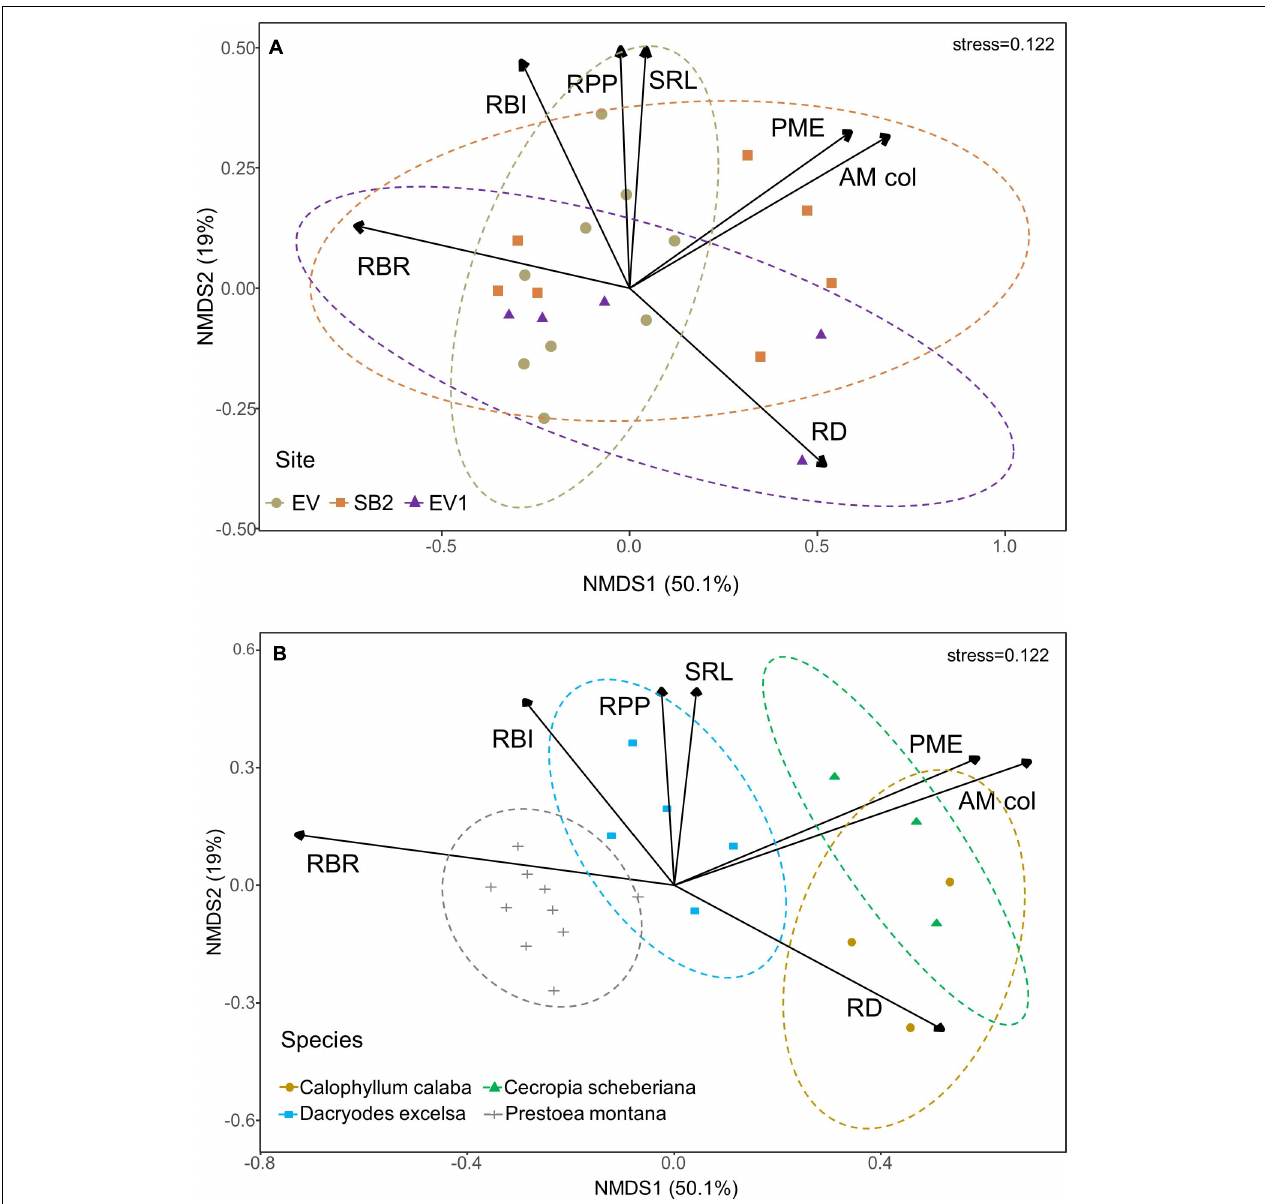
FIGURE 2 | Functional root traits of the first two fine-root orders of five common tree species at the Luquillo Experimental Forest in Puerto Rico. Non-Metric Multi-Dimensional Scaling (NMDS) of the fine-root traits: root branching ratio (RBR), root branching intensity (RBI), specific root length (SRL), root phosphatase activity (phosphomonoesterase; PME), root diameter (RD), root phosphorus concentration (RPP), and arbuscular mycorrhizal colonization (AM col). The NMDS plots are grouped by (A) Sites and (B) Species. Data are shown after the hurricanes that passed over the island in 2017. Due to sampling constraints, root PME activity was not measured for Spathodea